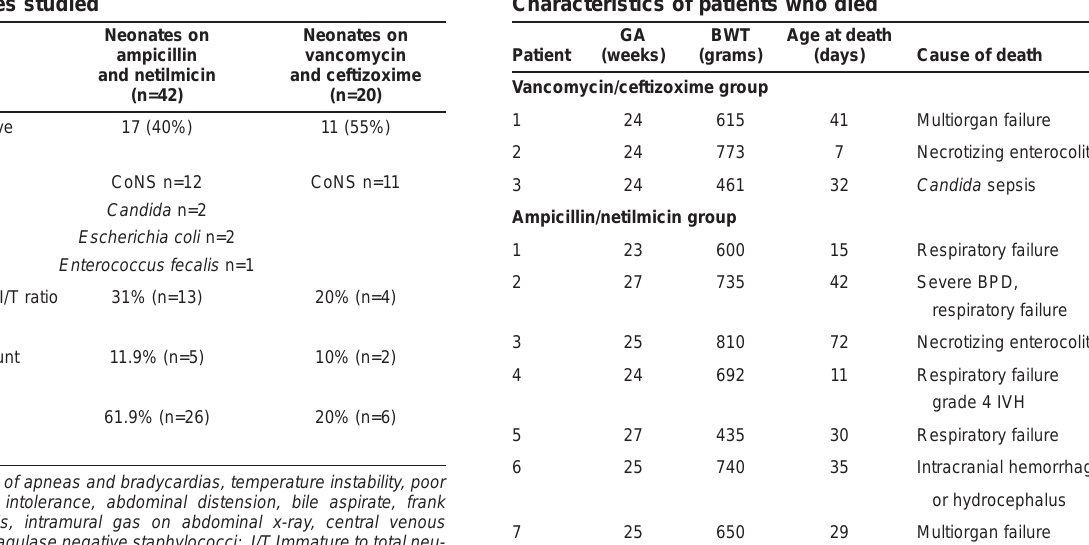
TABLE 2 Sepsis episodes studied